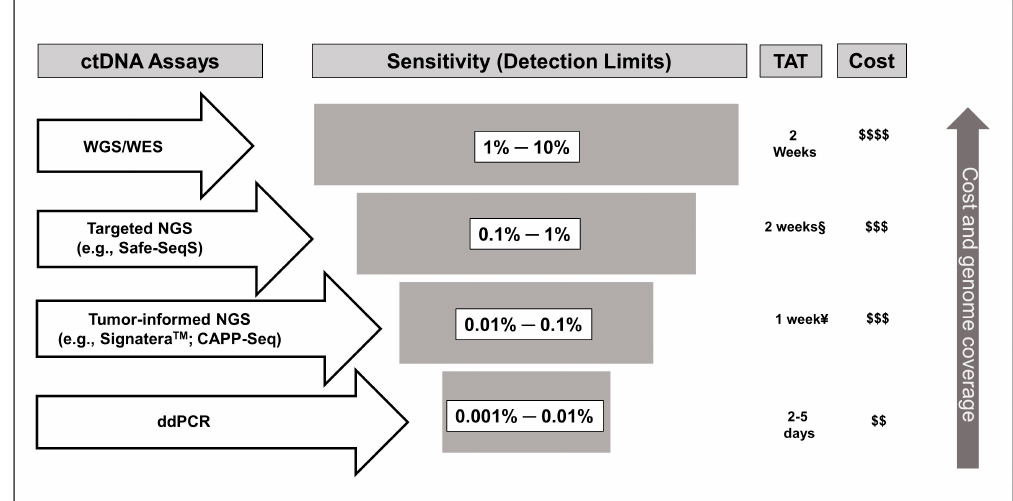
Figure 1. Schematic representation of sensitivity, turnaround time (TAT), cost, and genomic coverage of di ff erent circulating tumor DNA (ctDNA) assay methods illustrating variation of detection